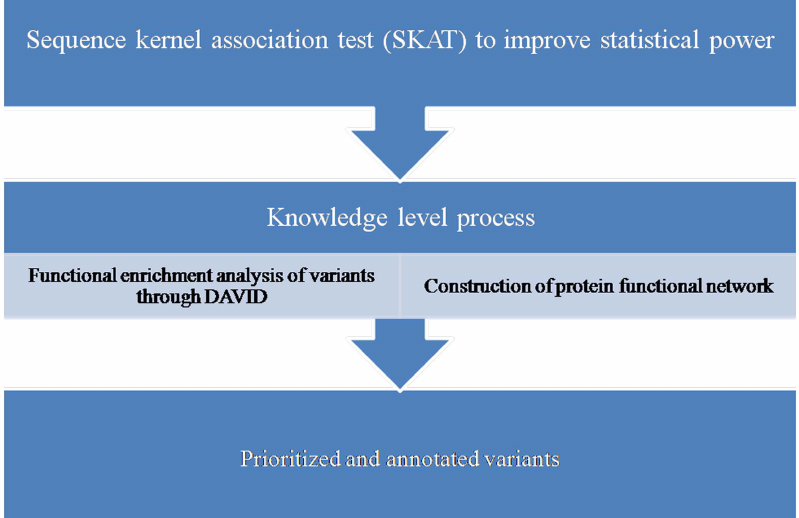
Figure 1. The filtration and prioritization framework used for data analysis.